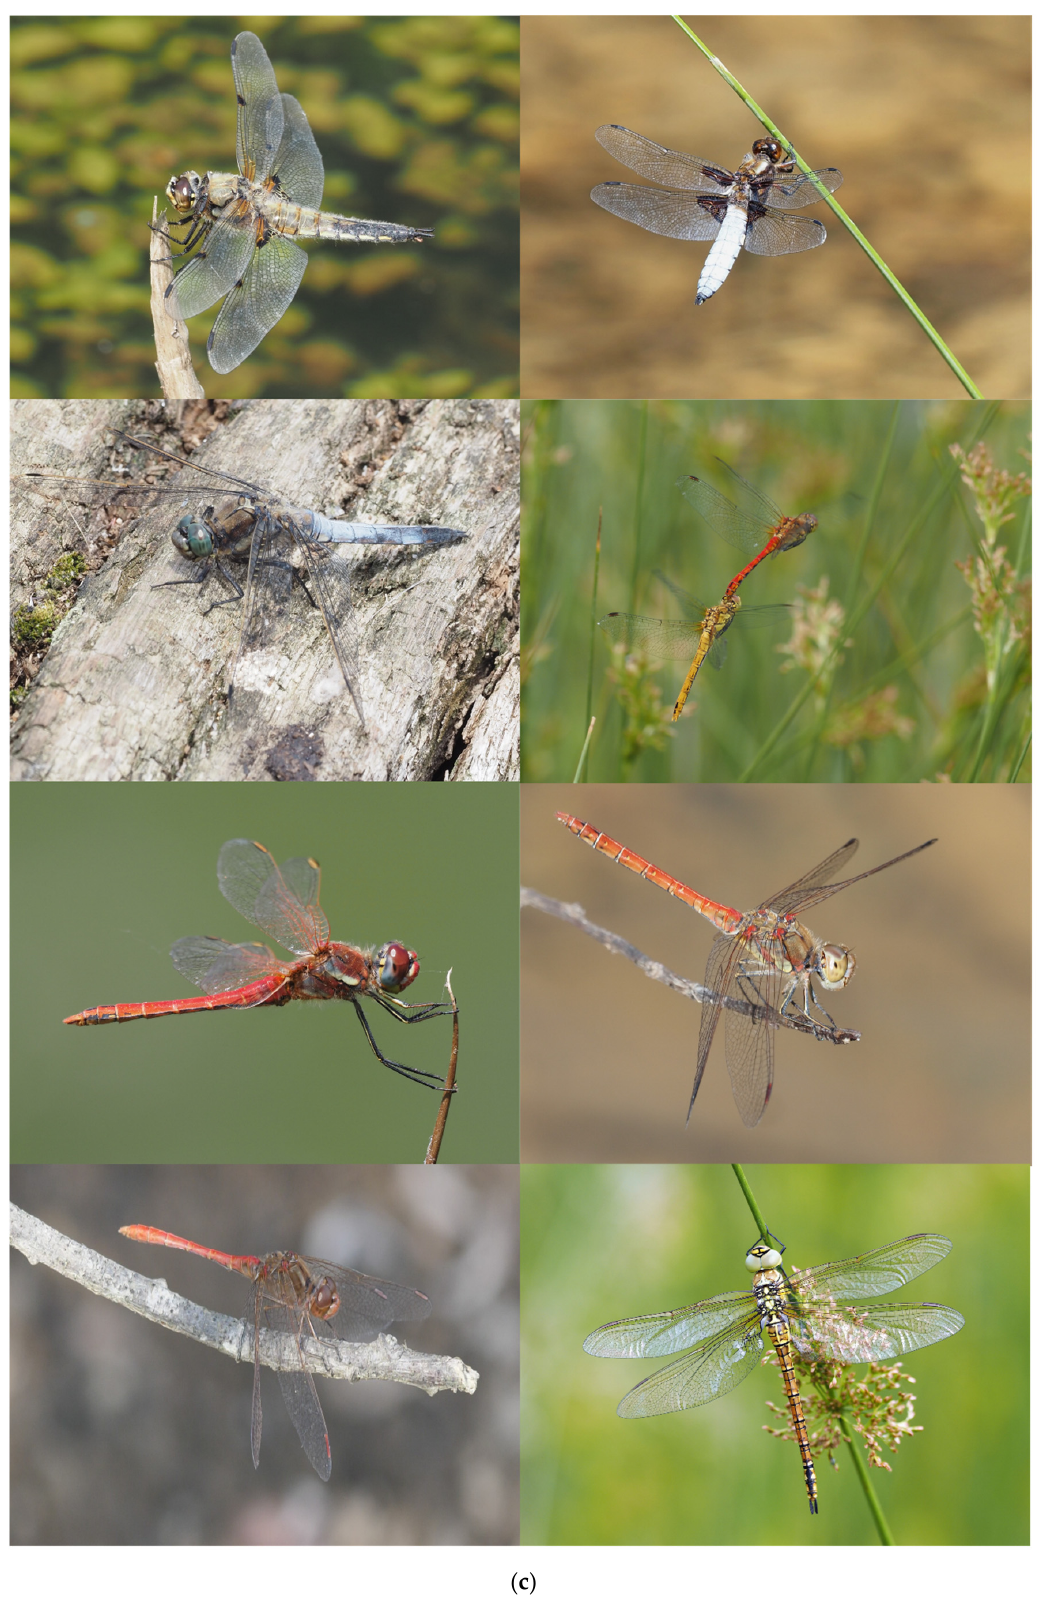
Figure 5. ( a ) Odonata species recorded in the Mondély reservoir (1). From left to right and top to bottom. Lestes barbarus (Fabricius, 1798) female, Chalcolestes viridis (Vander Linden, 1825) ovipositing